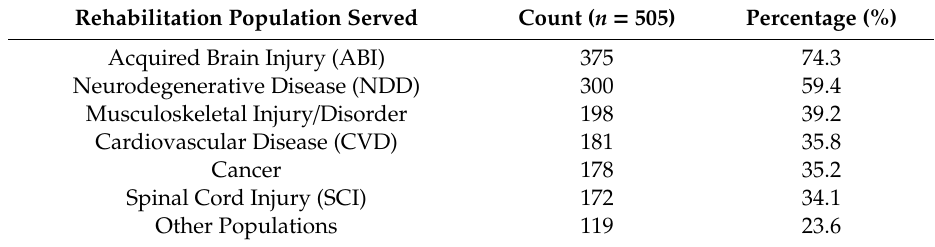
Table 2. Respondents by rehabilitation population served (number and percentage of